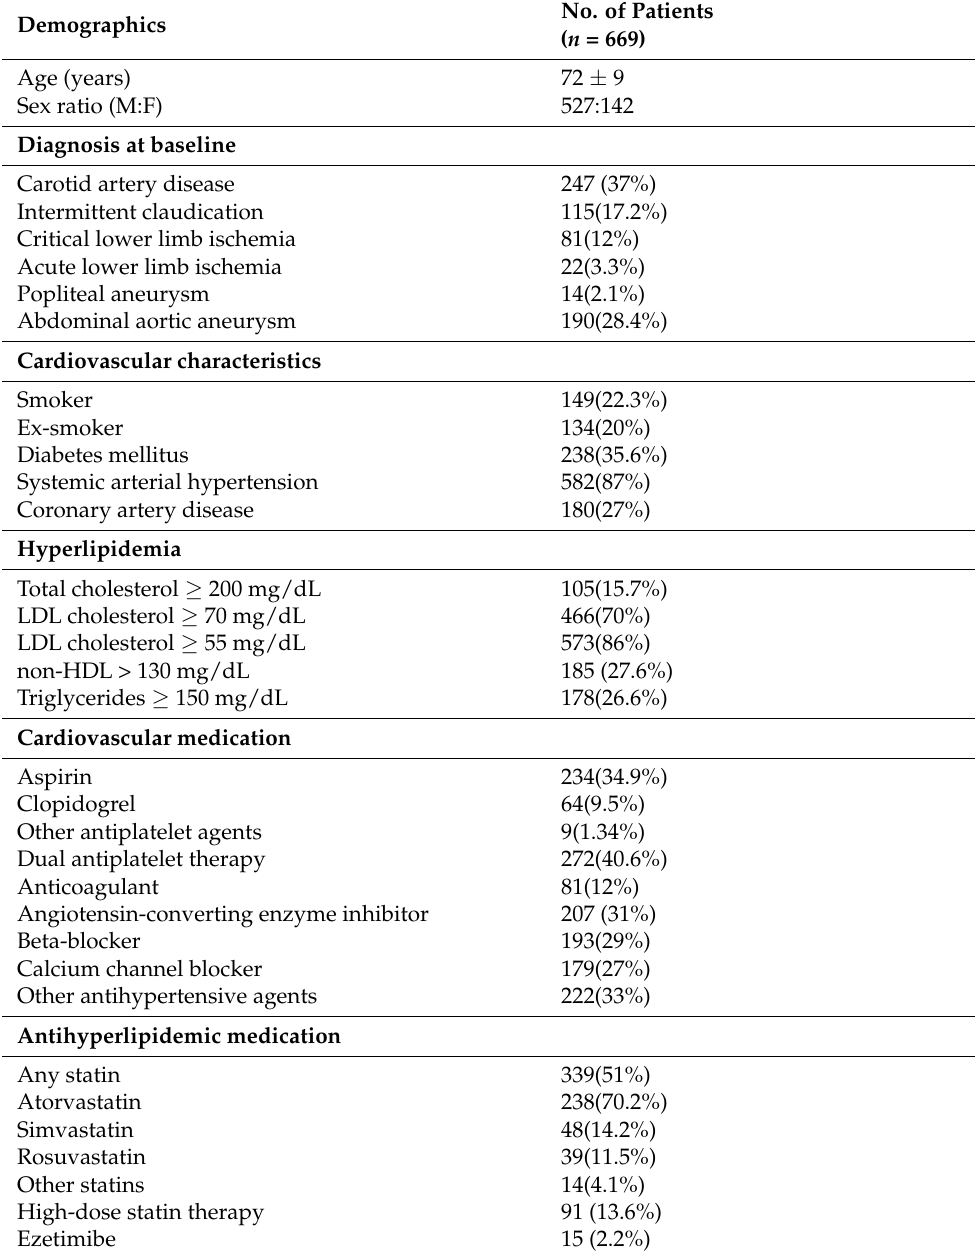
Table 1. Clinical characteristics of the population at